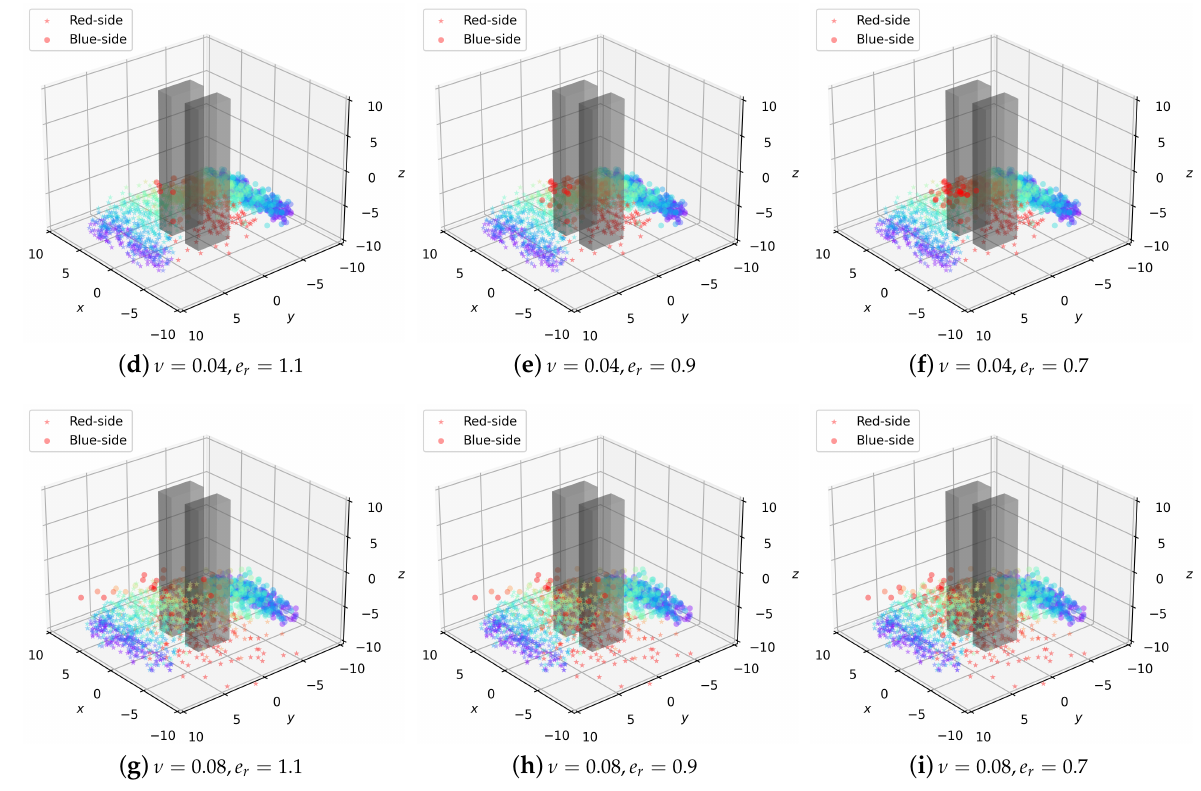
Figure A1. The 3D run diagram of large-scale UAV attack and defense behaviors under different stochasticity parameters and different capture radii.